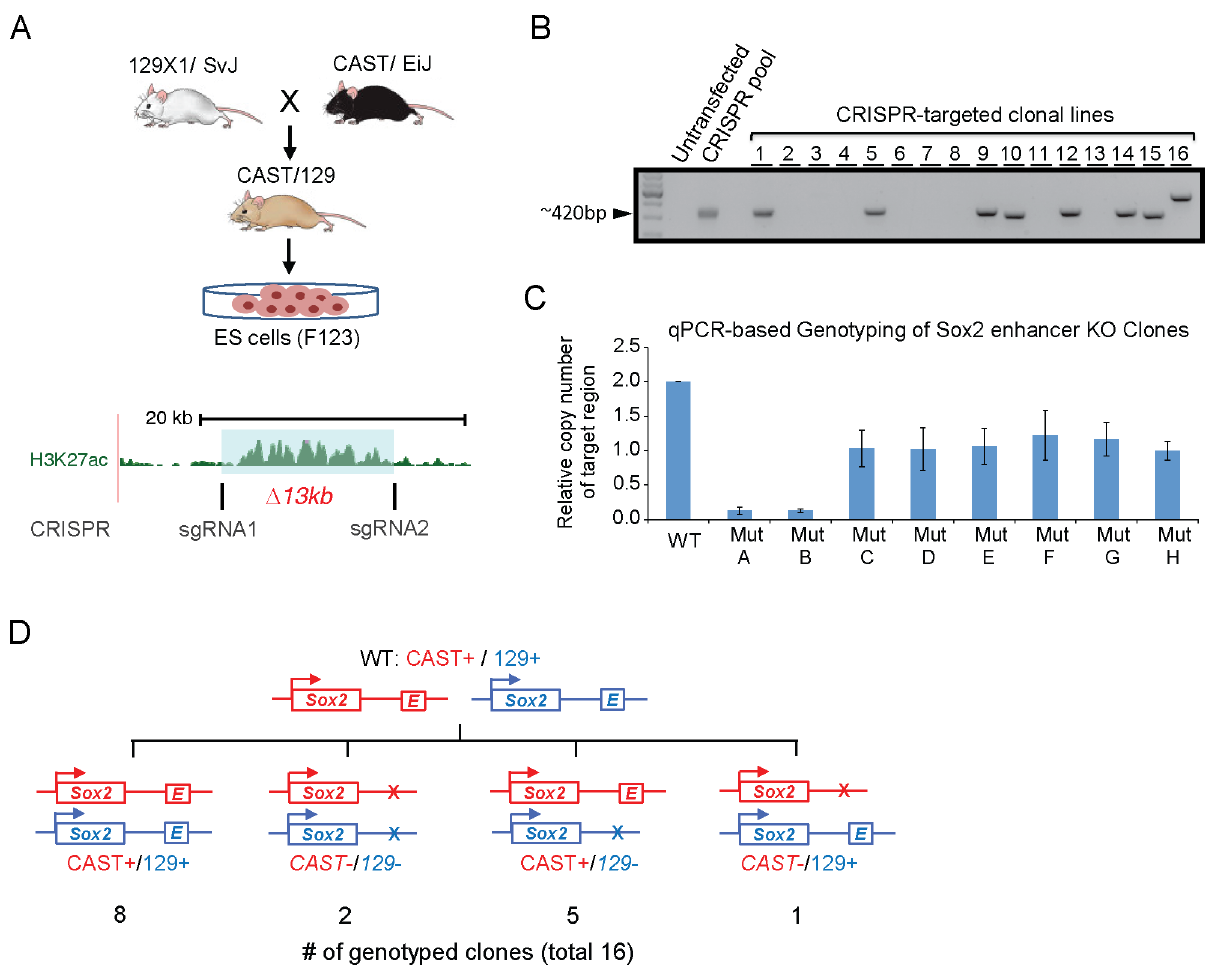
Figure 3. Deleting Sox2-SE using CRISPR. distal ( A ) Schematic representation of CRISPR-based SE deletion strategy in a hybrid mouse ESC line, F1-